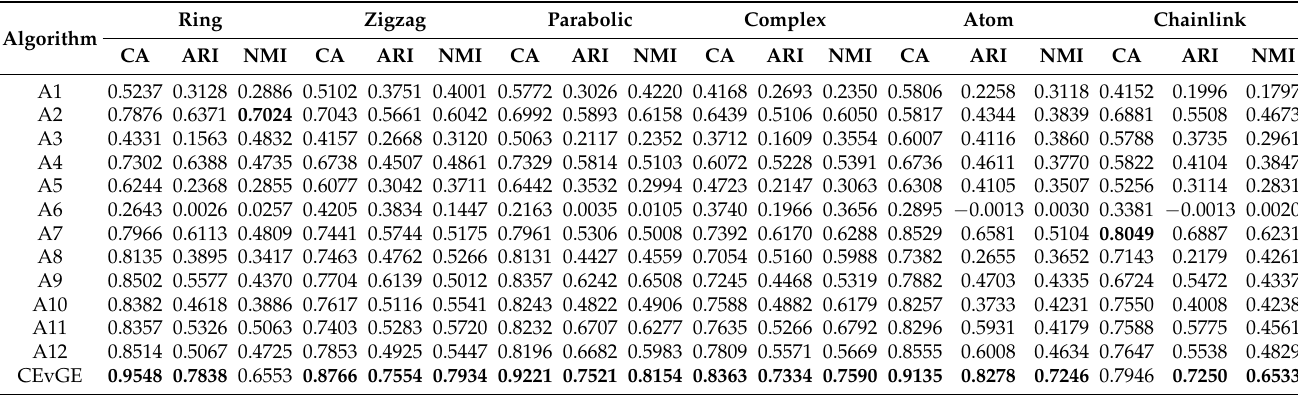
Table 3. External indexes of different algorithms on synthetic data